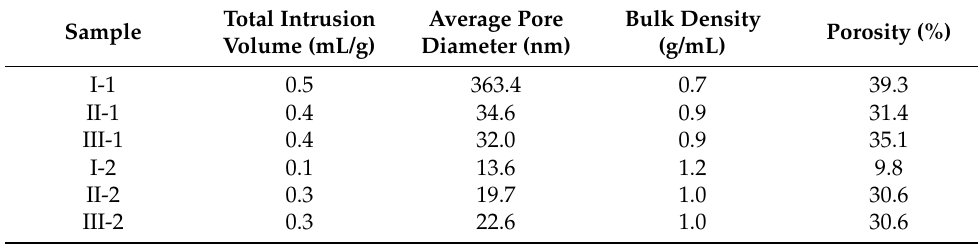
Figure 5. Optical microscopy images of the LC cross-sections. Table 2. Mercury intrusion porosimeter (MIP) results for the LC